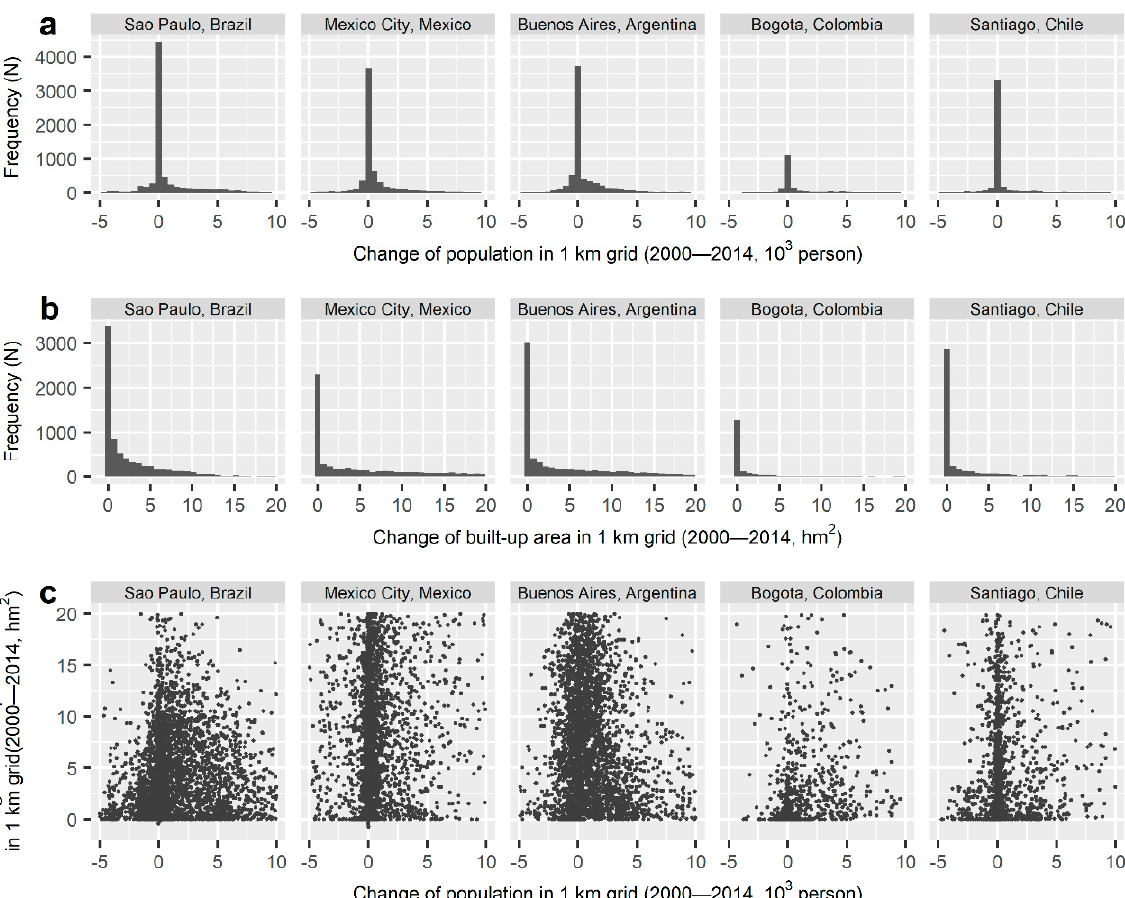
Figure 7. Frequency distribution and correlation analysis between the population growth and the urban land expansion from 2000 to 2014 in five Latin American cities. ( a ) Frequency of population change; ( b ) Frequency of built-up area change; ( c ) Scatter plots of population change and built-up area change in each 1 km grid.